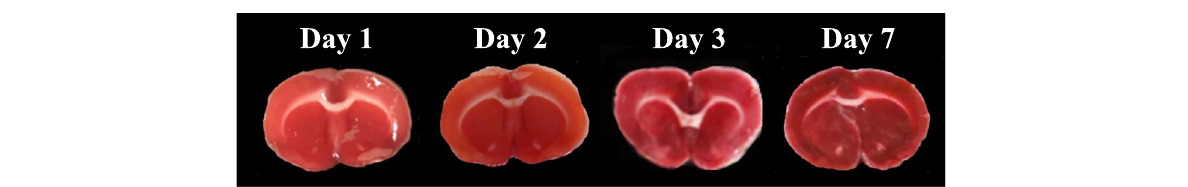
Fig. 2 Typical 2,3,5-triphenyltetrazolium chloride (TTC)-stained images in the brain after mild focal ischemia. Coronal sections at the level of the striatum were prepared at 1, 2, 3, and 7 days after 20-min middle cerebral artery occlusion (MCAO). The left side of each image is the ipsilateral side